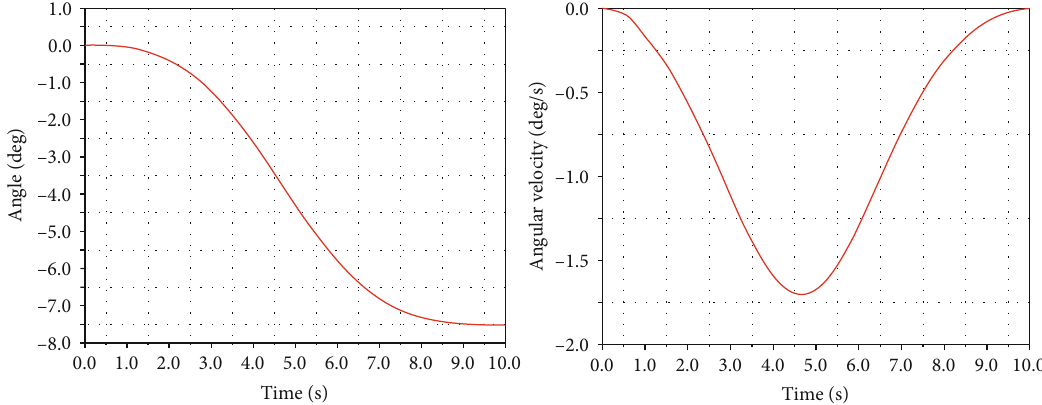
Figure 10: Optimized trajectory of the base for the planning case of attitude adjustment.